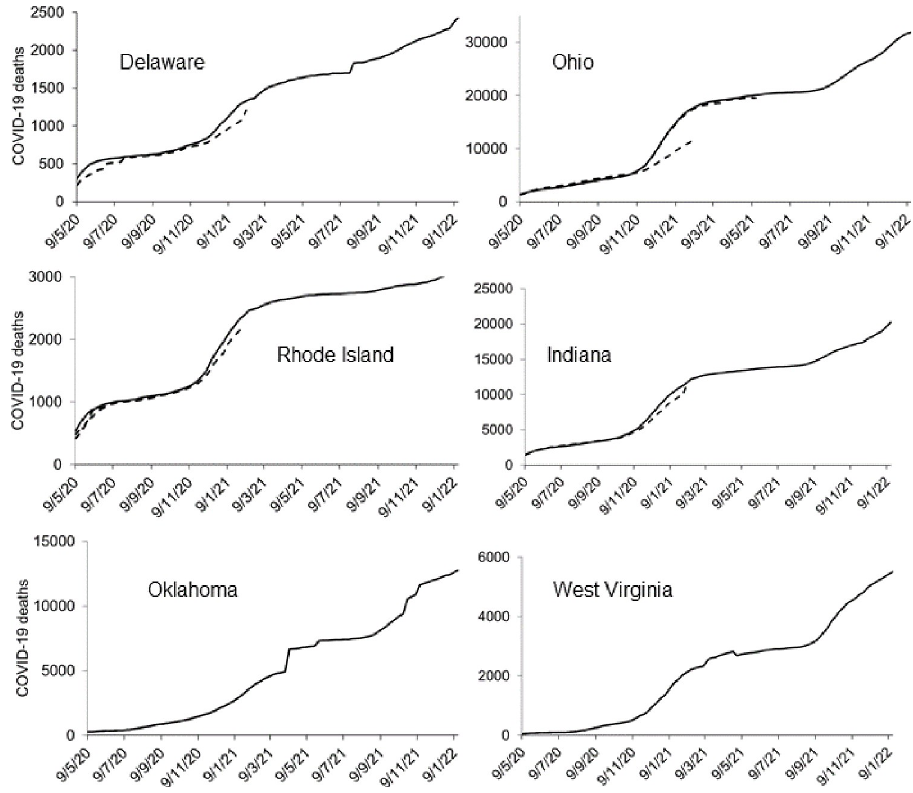
Fig 6. Numbers of reported cumulative deaths in six states where there were noticeable changes in reporting patterns. Based on reported death counts at multiple data points between 20 June 2020 and 15 January